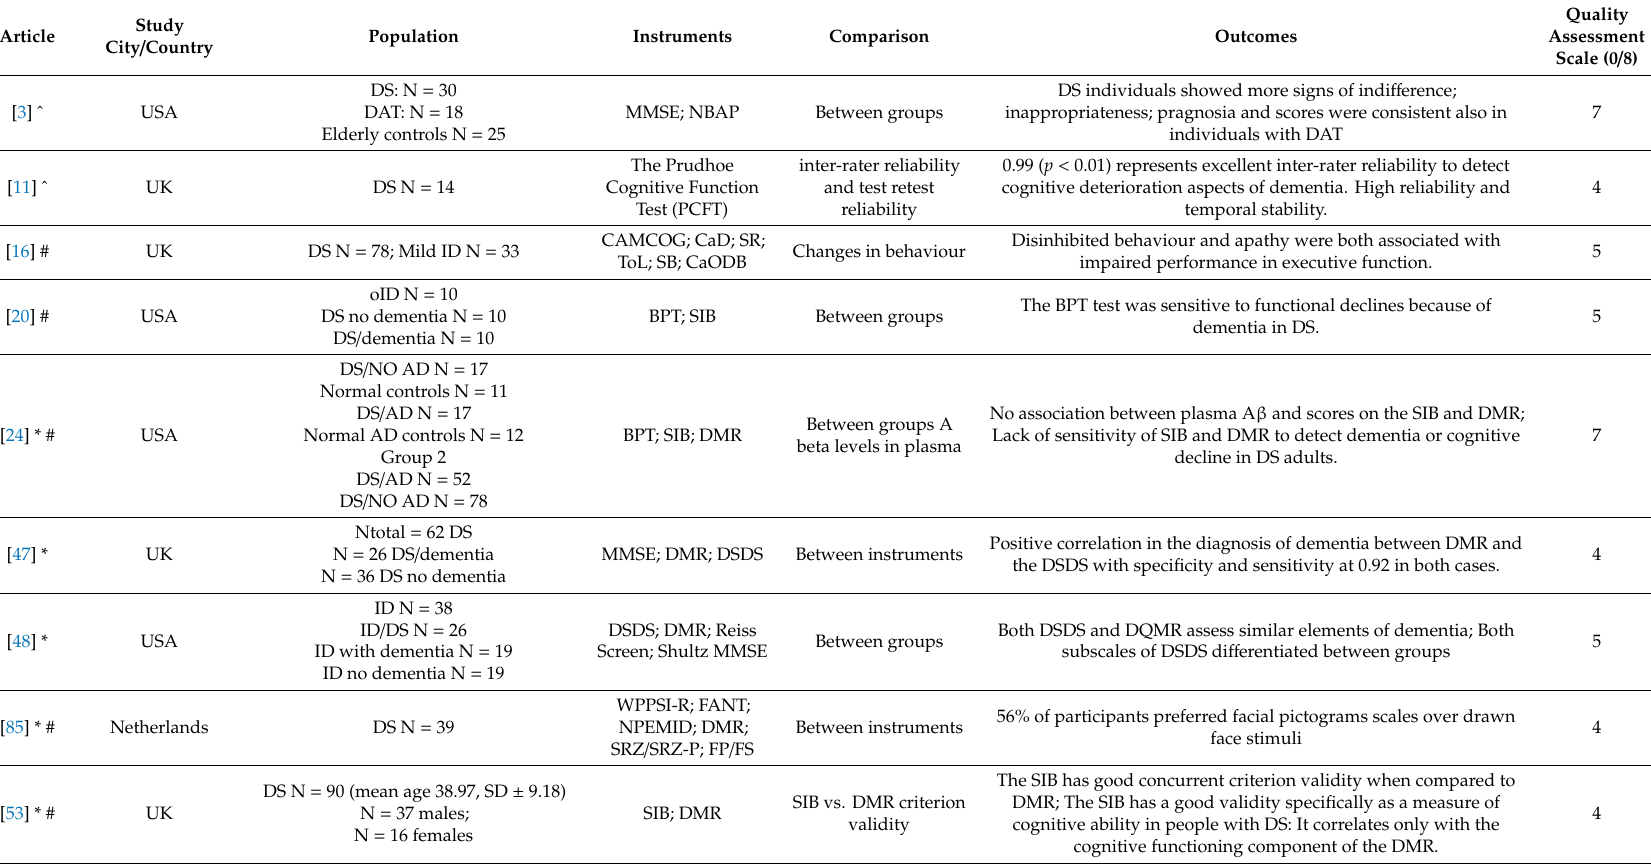
Table A1. Cross-Sectional Studies assessing cognitive changes in ID and ID-DS